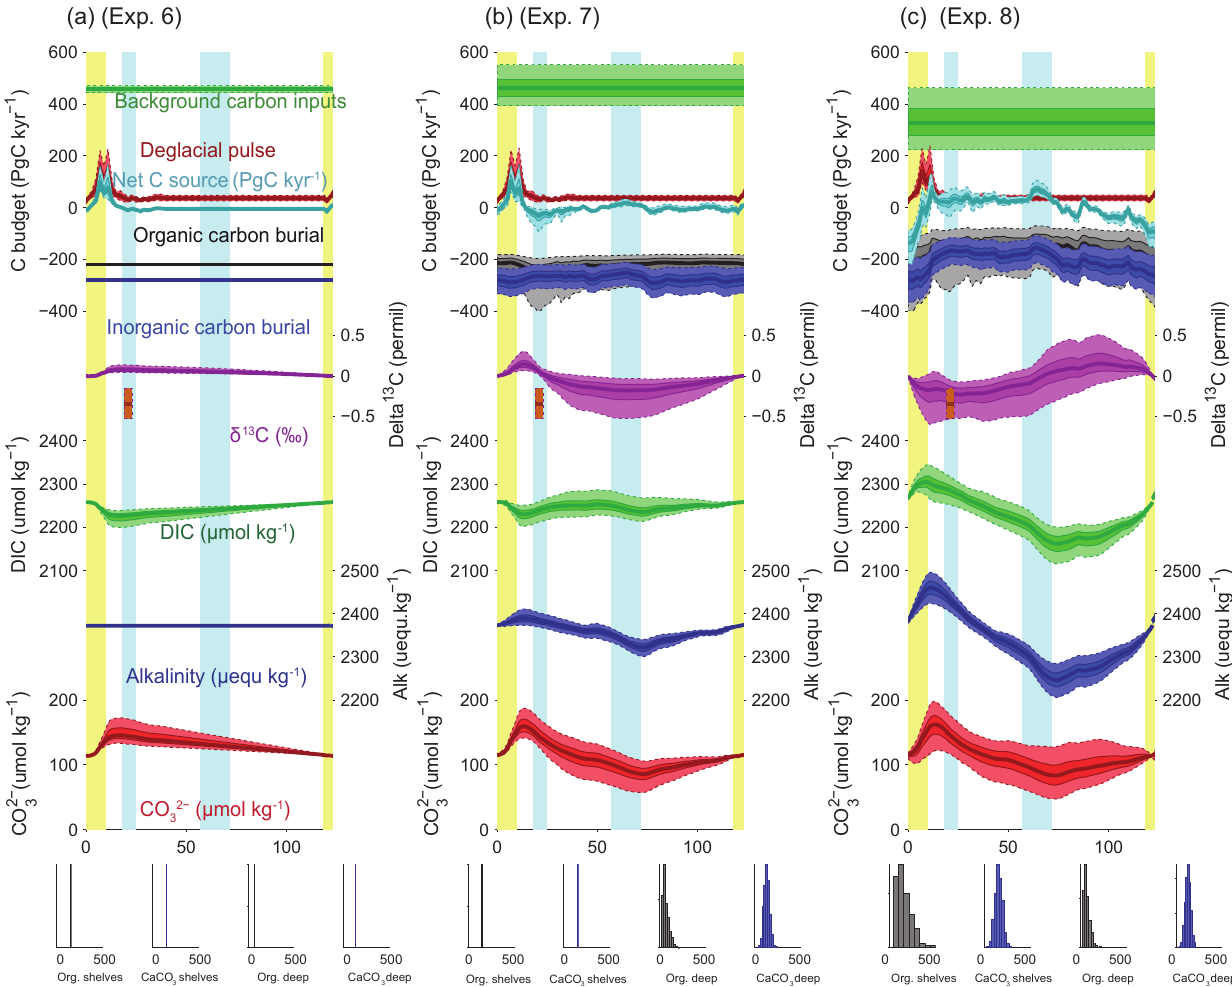
Figure 10. Simulated impacts of variable burial and outgassing fluxes on carbon and alkalinity inventories: (a) deglacial carbon input pulses, (b) variable deep-sea burial plus deglacial carbon input pulses, and (c) all variable (deep-sea burial, shelf burial, and deglacial carbon input pulses). All quantities and bars are plotted as in Fig. 7, with the addition of time-varying carbon input pulses based on subaerial volcanic emission (Huybers and Langmuir, 2009) in